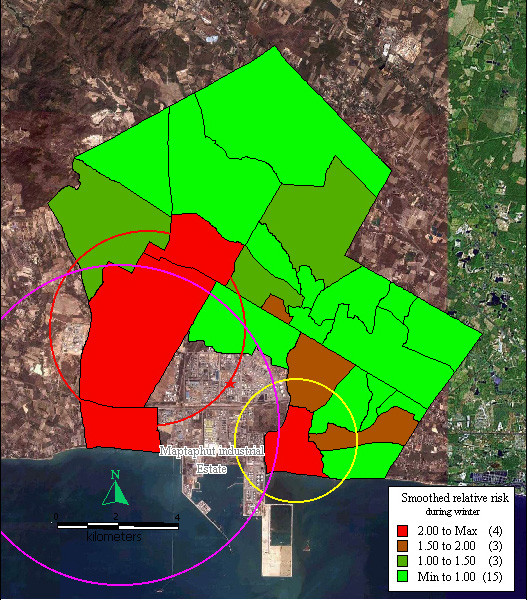
Mapping of smoothed relative risk and disease clusters in the study area during winter. Red circle indicates the first cluster of respiratory disease that includes Mapchalood, Taladhauypong and Watsopol. Yellow circle indicates the second cluster of respiratory disease and includes Takuanaupradoo, Koakoknongtungmea and Nongnamyen. Magenta circle indicates the third cluster of respiratory disease that includes Nongpab, Mapchalood and Watsopol. Red star sign indicates weighted mean centre of the stacks.